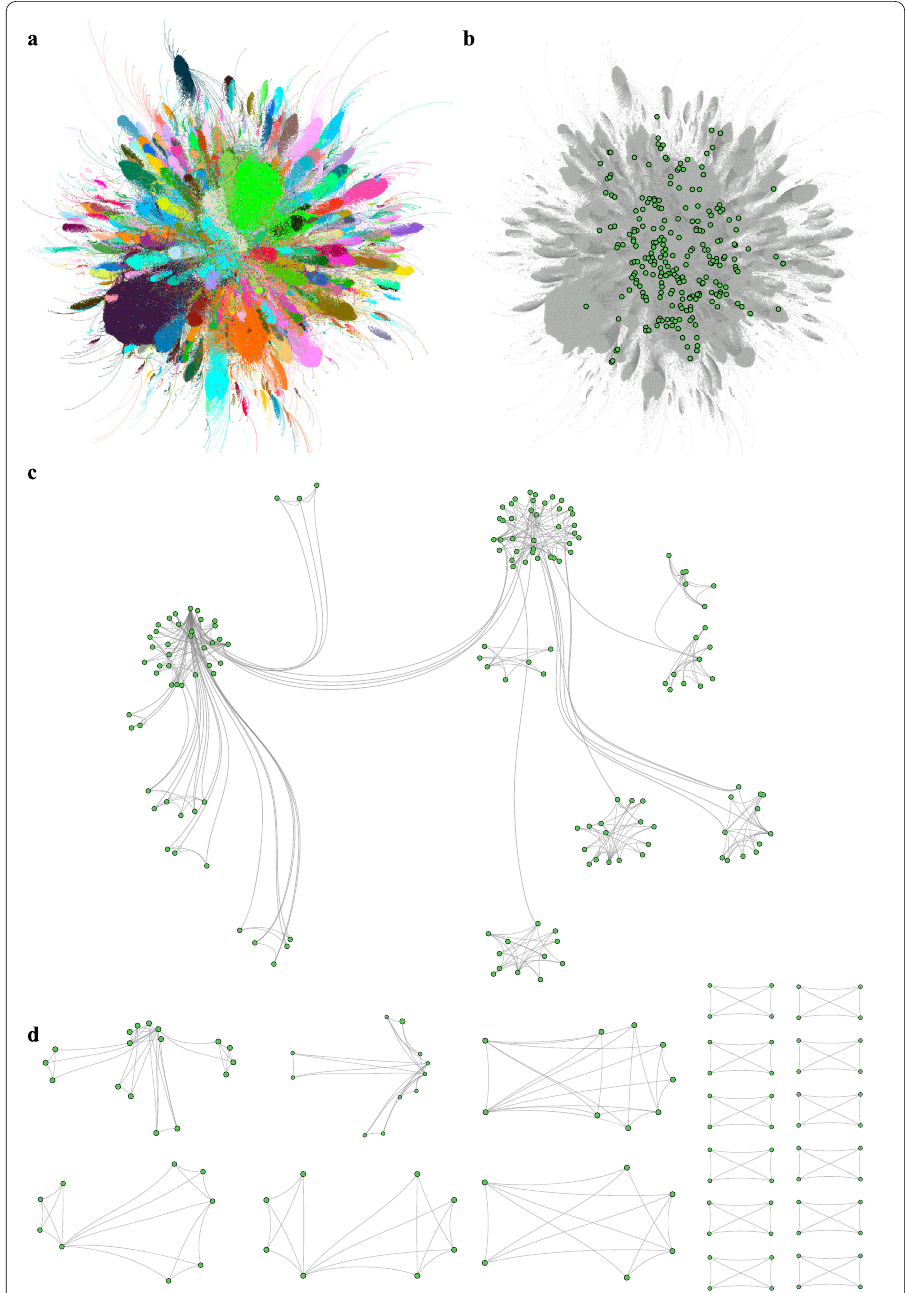
Figure 5 Reduced k -Cliques and Emerging Suspicious Groups in the Bahamas Leaks. ( a ) Communities in the Bahamas Leaks network. ( b ) Position of suspicious nodes in the Bahamas Leaks network (zoom). ( c ) Largest connected component of the set of all nodes belonging to 4-cliques of the reduced Bahamas Leaks network. ( d ) The remaining connected components of the set of nodes from 4-cliques of the reduced Bahamas Leaks